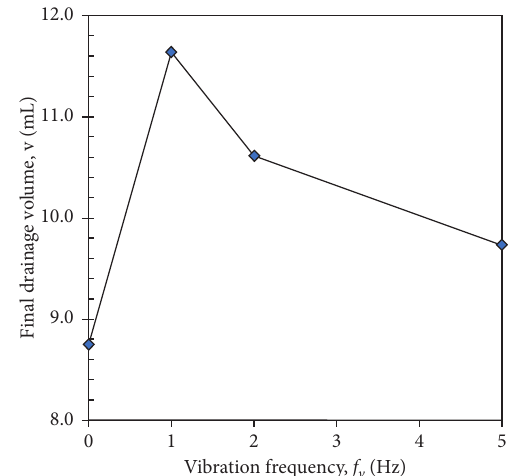
Figure 4: Variation of final drainage volume with vibration